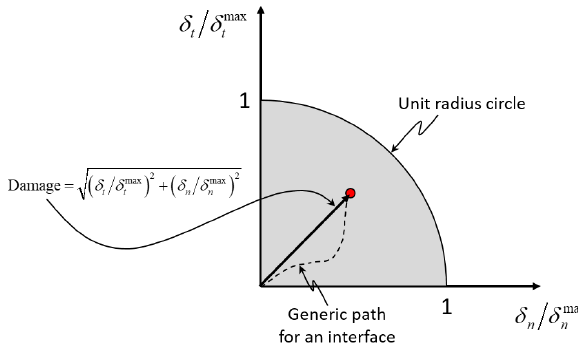
Figure A1. Connection between the normal and tangential failure modes, as implemented in